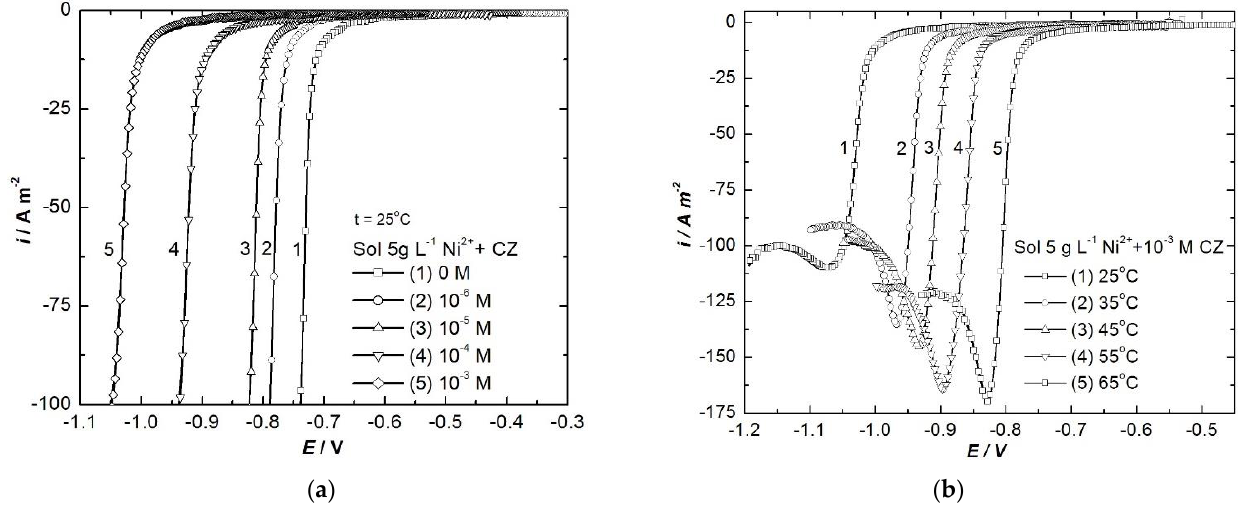
Figure 5. LVs recorded for nickel electrodeposition without and with different concentrations of CZ at 25 °C ( a ) and with 10 − 3 mol L − 1 CZ at different temperatures ( b ), 2 mV s − 1 scan rate.